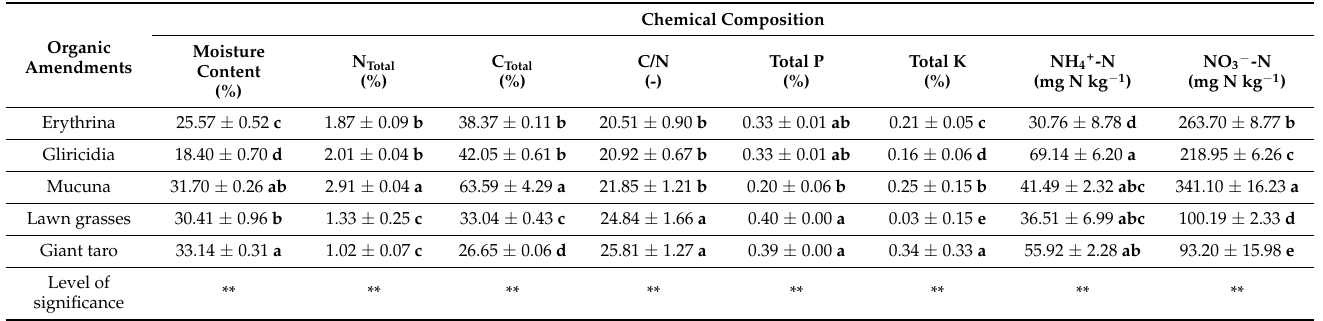
Table 2. Characteristics of composts used in both